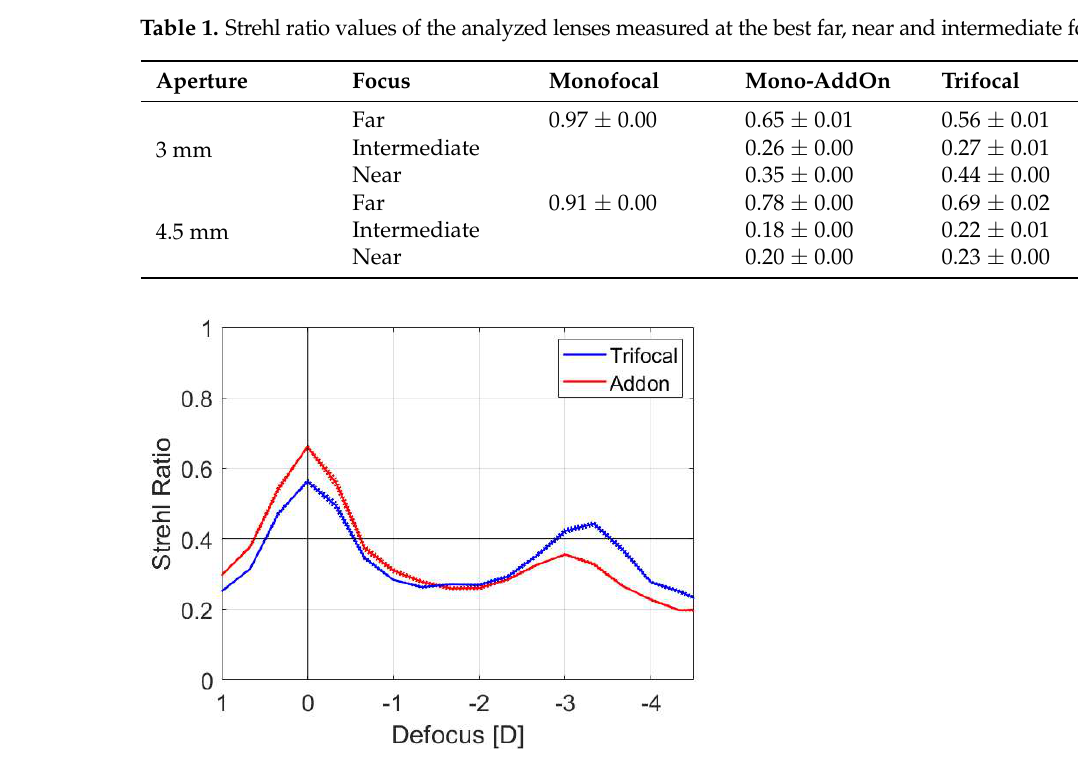
Figure 3. Strehl Ratio as a function of defocus. A higher Strehl Ratio indicates a better optical quality. Both the trifocal and AddOn IOL showed two peaks, corresponding to the far and near focus. Table 1. Strehl ratio values of the analyzed lenses measured at the best far, near and intermediate focus.